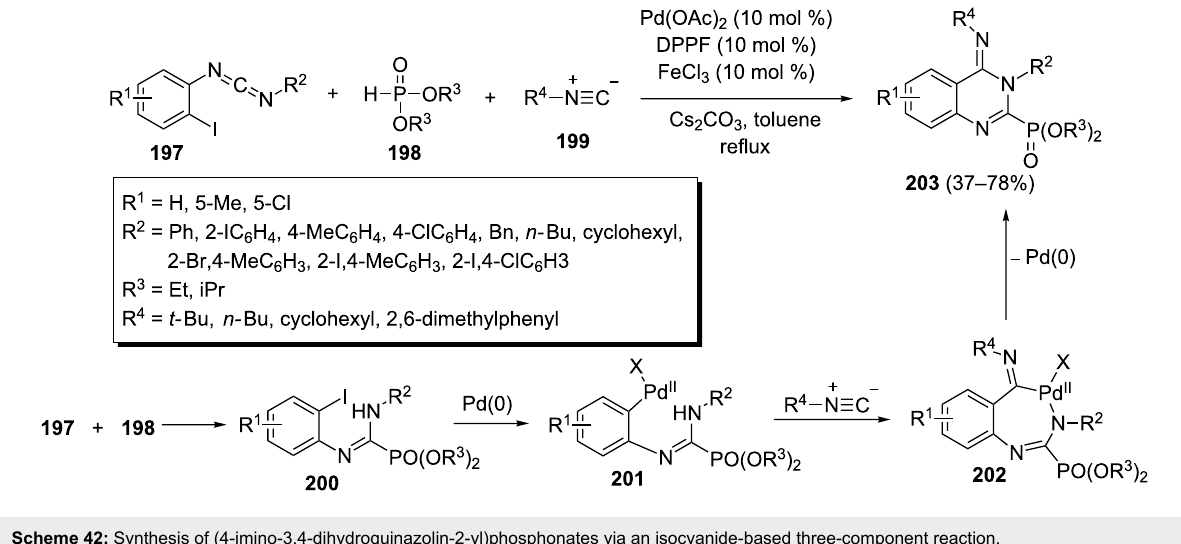
Scheme 42: Synthesis of (4-imino-3,4-dihydroquinazolin-2-yl)phosphonates via an isocyanide-based three-component reaction.